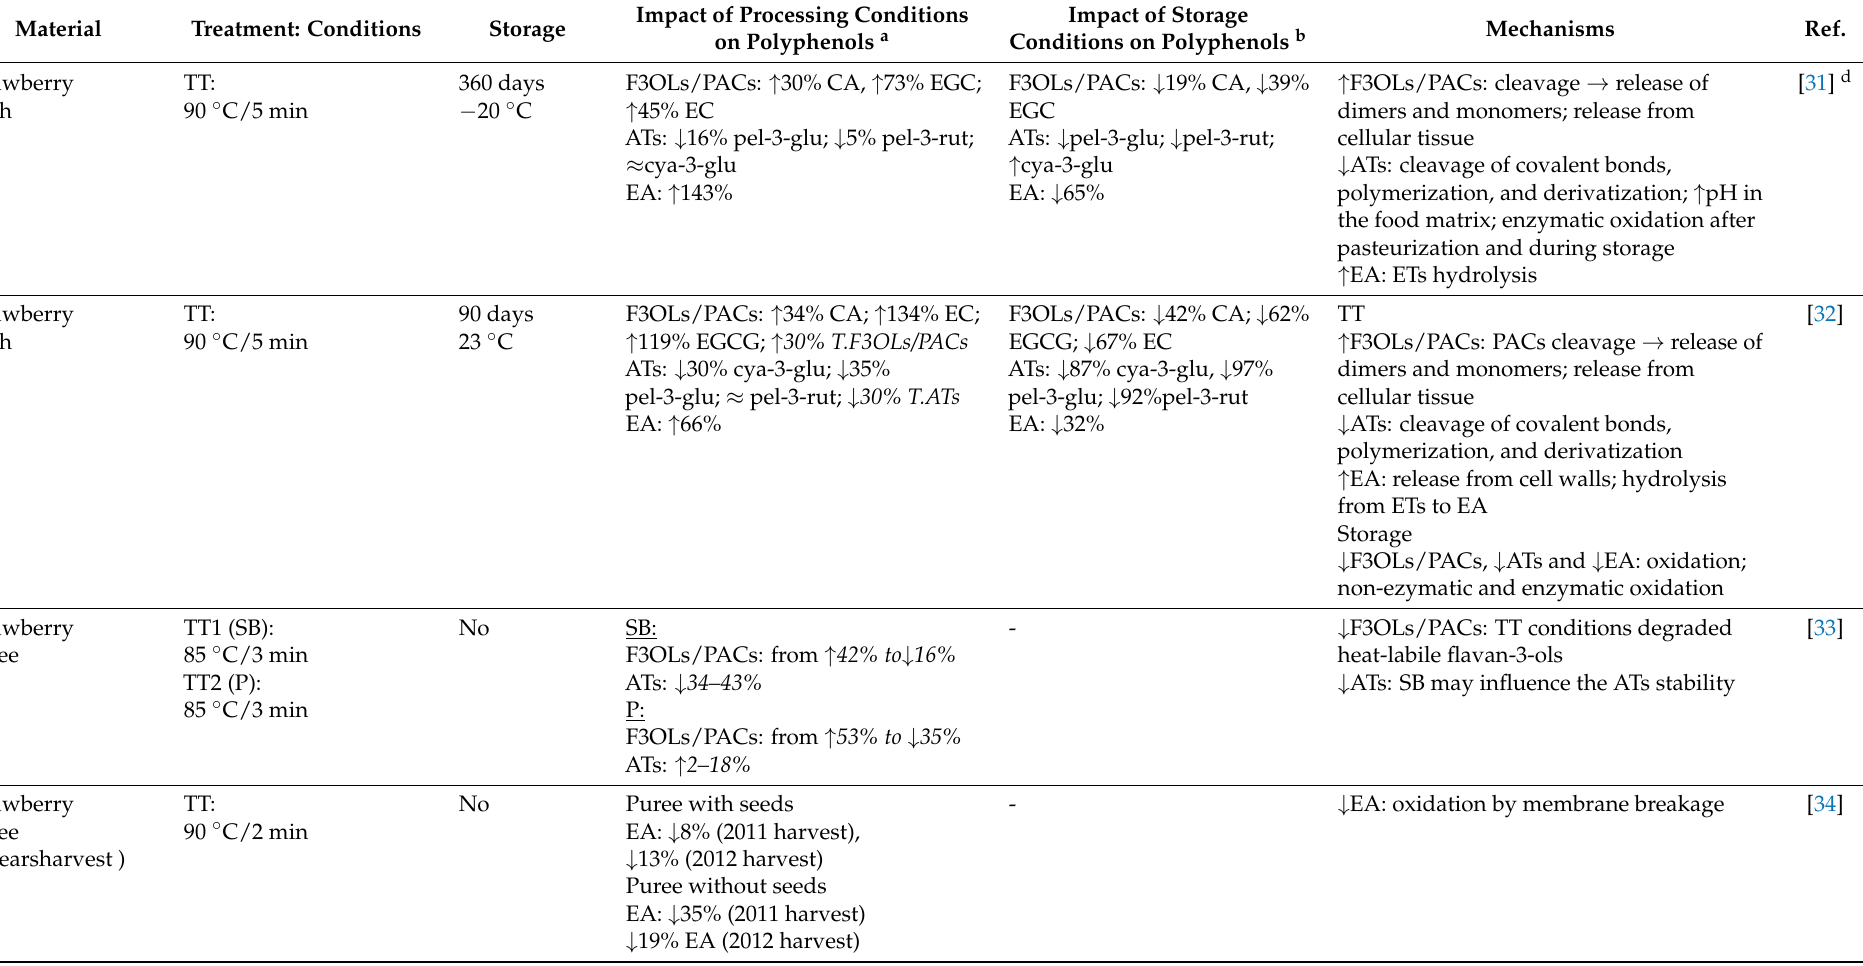
Table 1. Effects of TT and HPP treatments and storage on the main phenolic compounds in strawberry